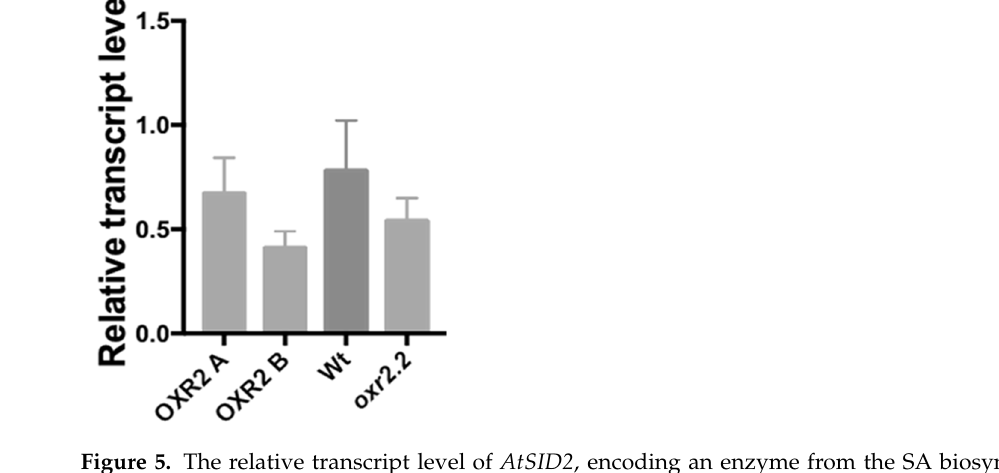
Figure 5. The relative transcript level of AtSID2 , encoding an enzyme from the SA biosynthetic pathway as a marker for its possible regulation. Relative transcription determined based on AtActin and by comparing the infected roots to the control roots 20 dai. Results are expressed as mean ± SD ( n = 3).